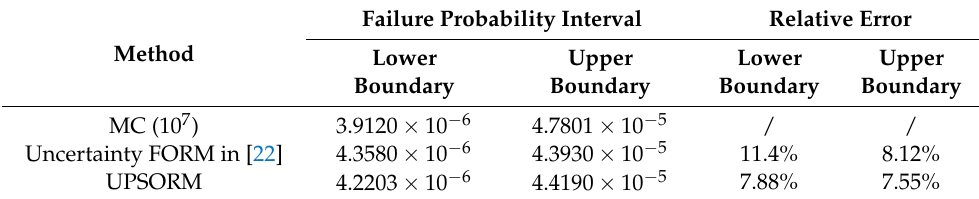
Table 3. The comparison of lower and upper bounds.